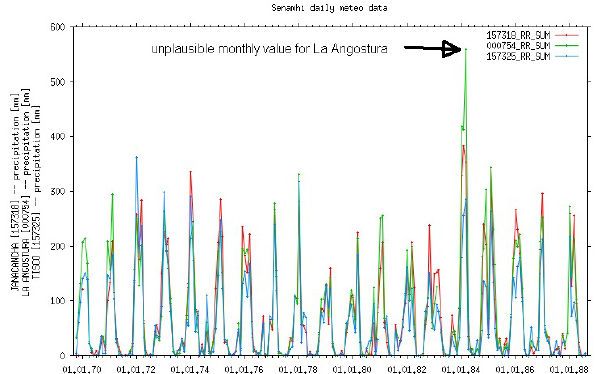
Figure 7. Detection of an unplausible value in a precipitation data series of the stations Janacancha (15.18 ◦ S, 71.77 ◦ W, 4320ma.s.l., in red), La Angostura (15.18 ◦ S, 71.65 ◦ W, 4150ma.s.l., in green) and Tisco (15.35 ◦ S, 71.45 ◦ W, 4175ma.s.l., in